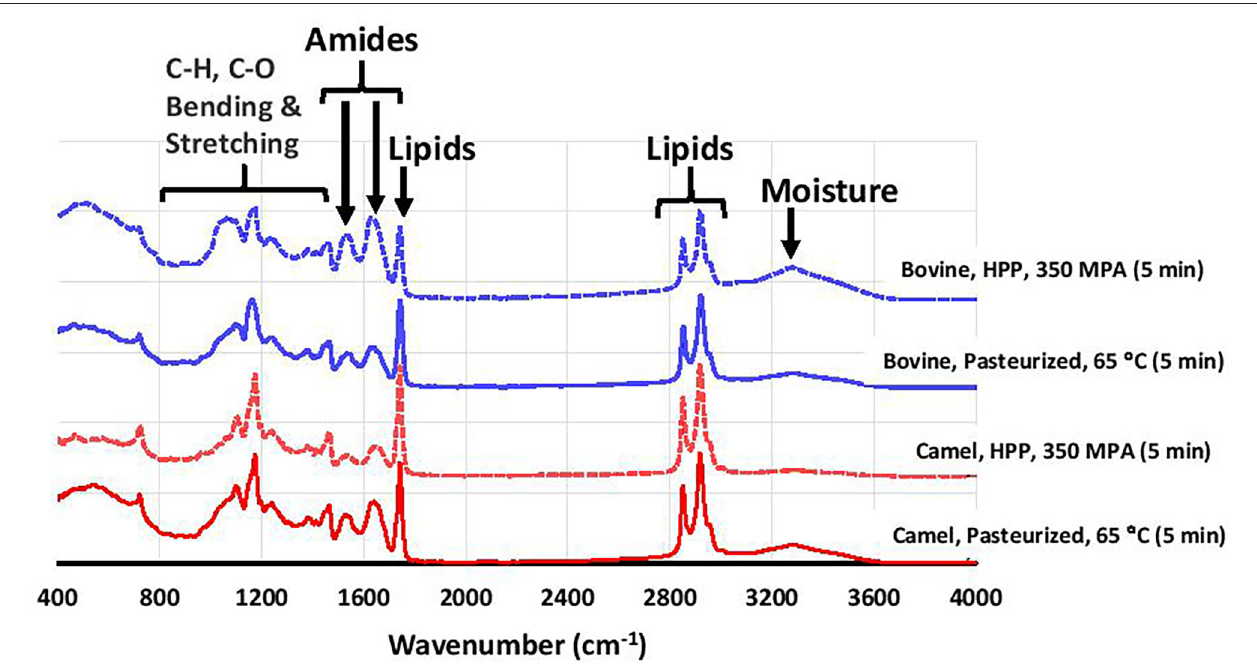
FIGURE 4 | FTIR spectra of selected bovine and camel milk cheeses prepared from heat pasteurization and HHP